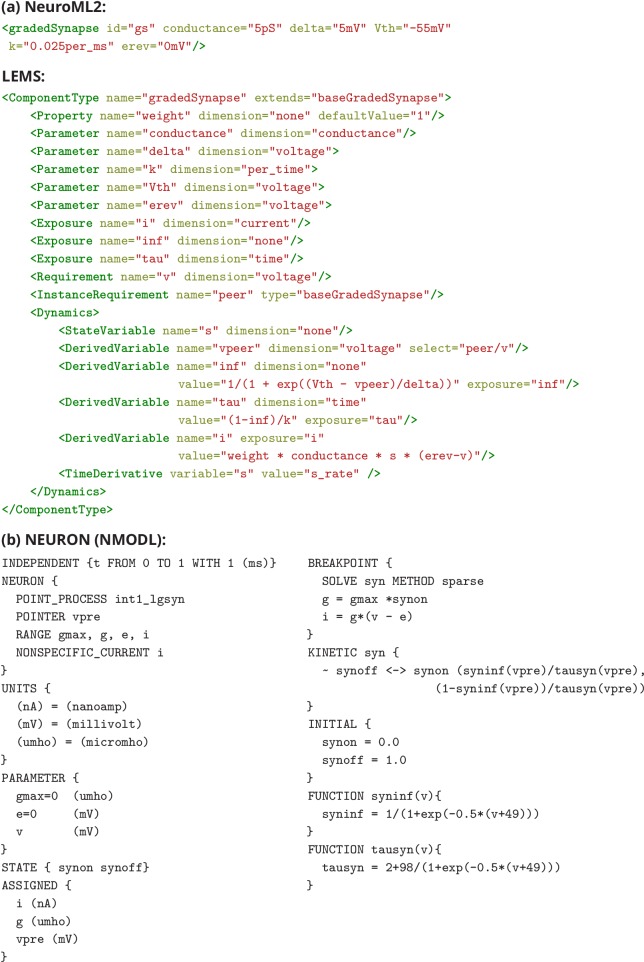
Graded synapse model (cont.).(a) Definition of a graded synapse model in NeuroML2/LEMS. The graded synapse model as described in Prinz et al. (2004) has been added as a “core type” to the (not yet finalized) NeuroML2 standard and can therefore be accessed under the name gradedSynapse (top). It is fully defined via the LEMS definition partially reproduced here. (b) A definition of a graded synapse in the stomatogastric system, written in the NMODL language for the NEURON simulator. This model has been implemented in Nadim et al. (1998), see https://senselab.med.yale.edu/ModelDB/showmodel.cshtml?model=3511.